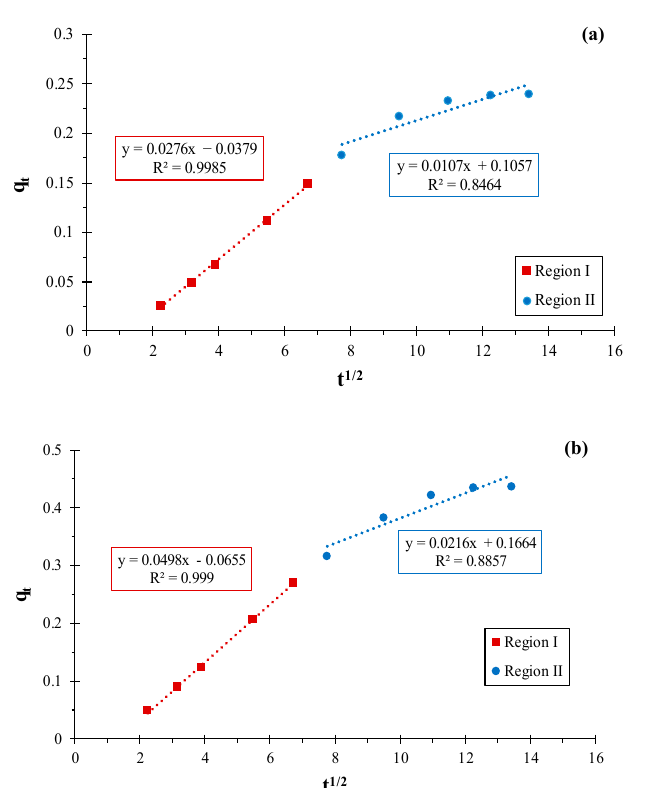
Figure 6. Bangham kinetic model representation for RhB adsorption on ( a ) KS44 ‐ 0 and ( b ) KS44 ‐ 20.